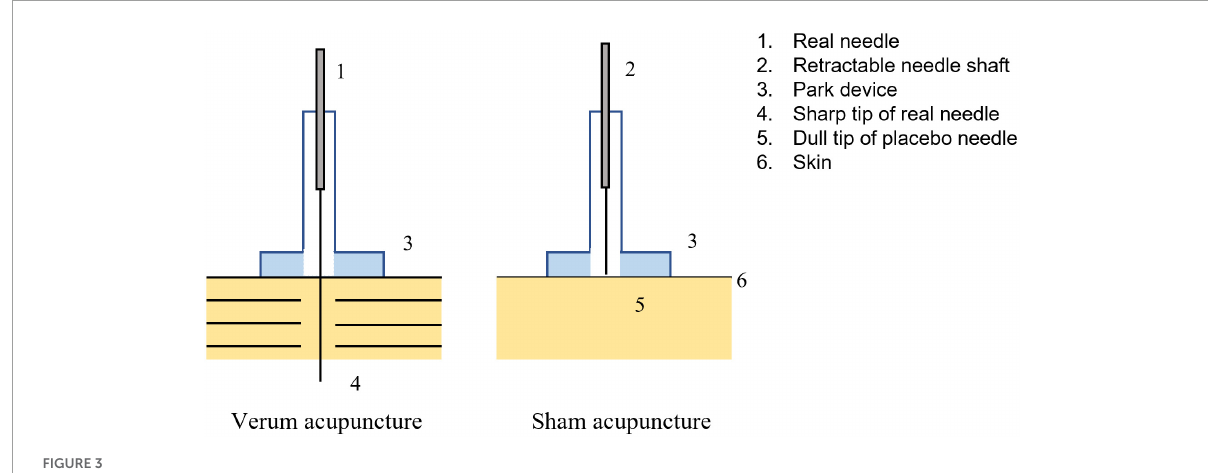
FIGURE3 Verum acupuncture and Sham